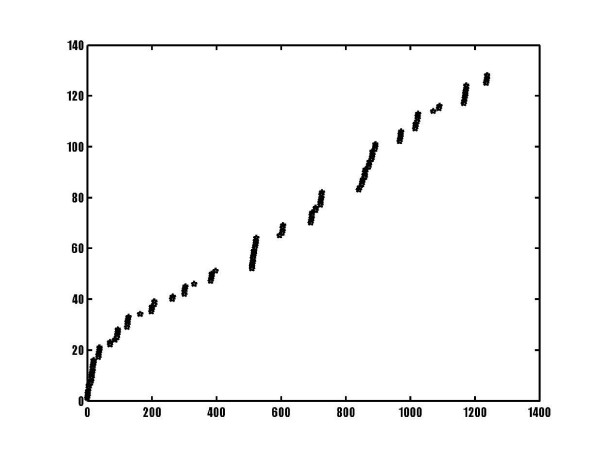
Spatial distribution of similar words in MSW L. Fairly uniform spatial distribution of start locations for words in the MSWL (n = 137, see Fig.1) of the knirps cis- regulatory region of Drosophila melanogaster . The X axis shows the positions of each word start in the sequence, the Y axis is the rank of this position in the list.